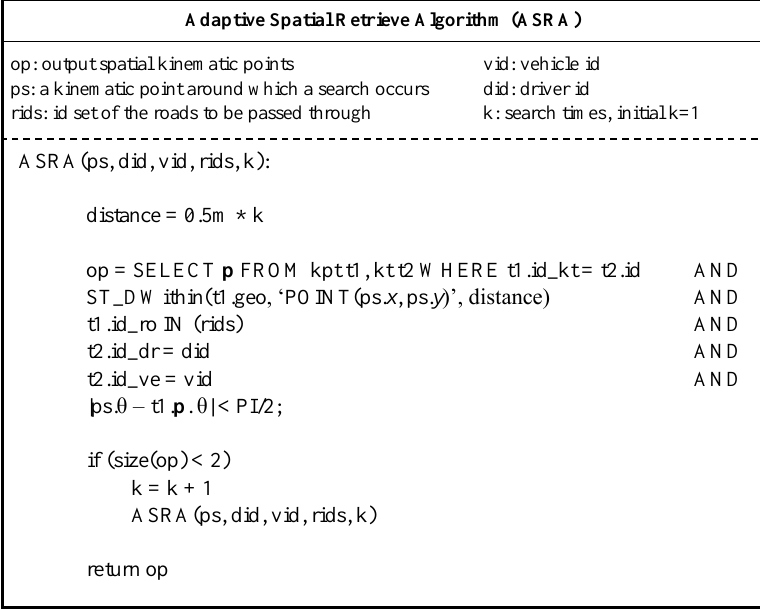
Figure 3. The proposed adaptive spatial retrieve